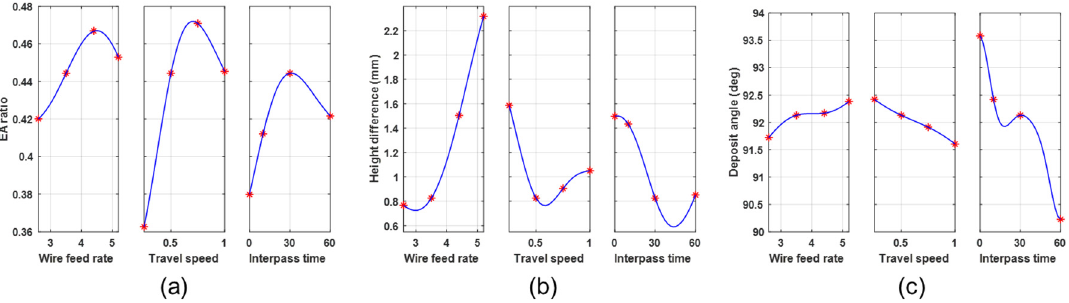
Figure 7. Output values of the Gaussian process regression (GPR) model (red asterisk indicates the experimental data).